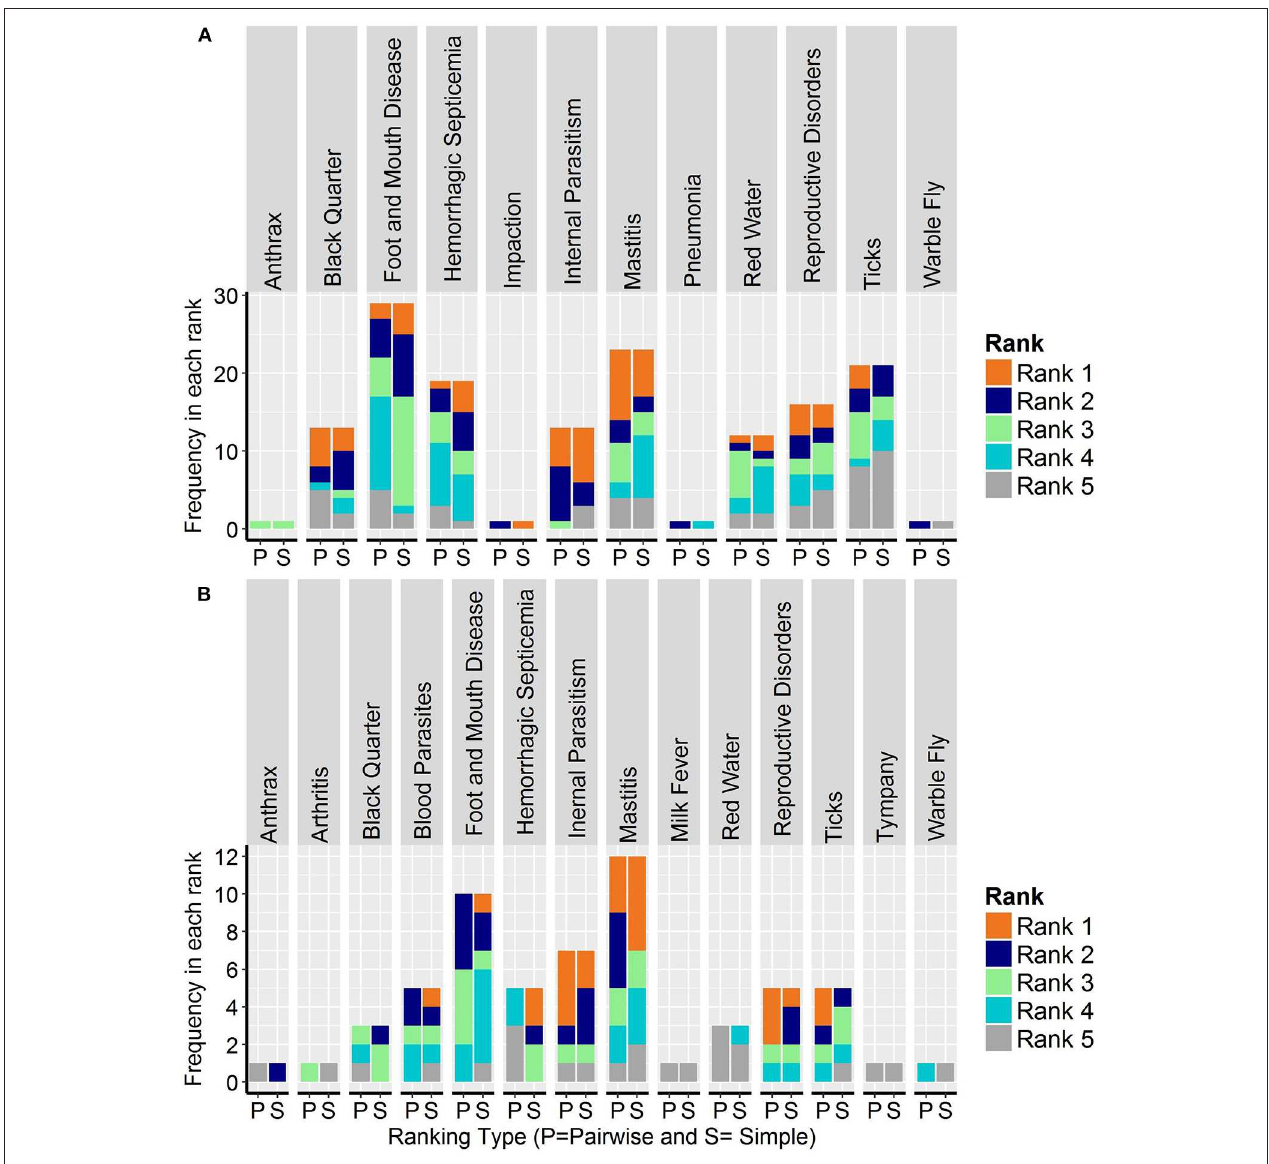
FIGURE 2 | Grouped stacked bar plots of simple and pairwise rankings of major bovine health and production constraints by farmers (A) and animal health professionals (B) .